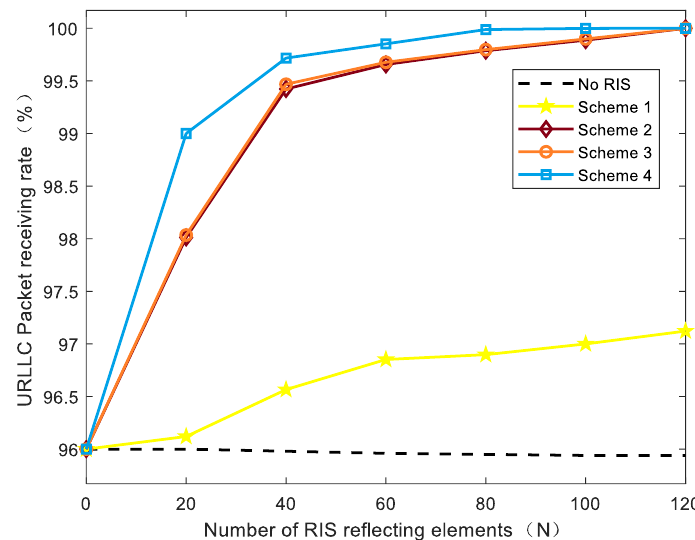
Figure 5. URLLC packet reception rate of different RIS phase shift matrices.